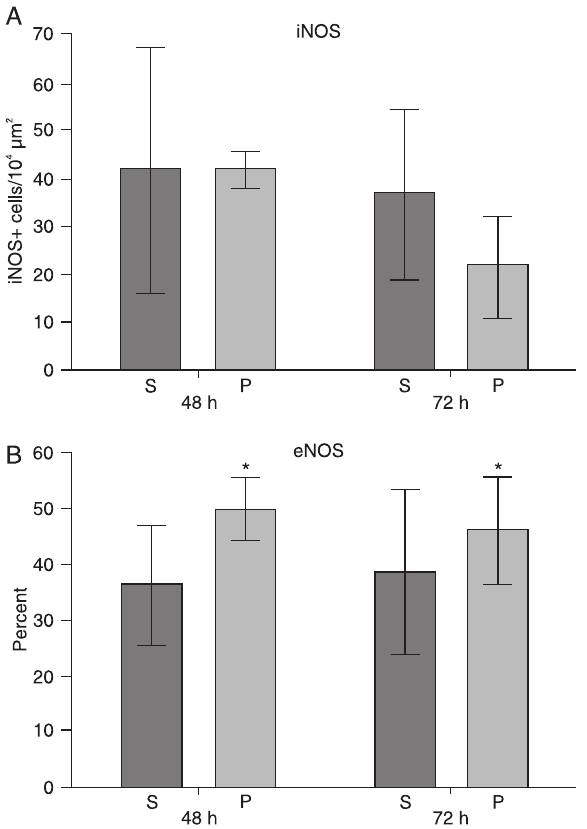
Figure 4. A , Inducible nitric oxide synthase (iNOS) expression with lower immunoexpression at 72 h in both groups. B , Endothe- lial nitric oxide synthase (eNOS) expression showing an increase in immunoexpression after pneumonectomy. Data are reported as mean ± CI 95% . S = sham-operated; P = pneumonectomy. *P < 0.05 compared to respective control groups (two-way ANOVA).